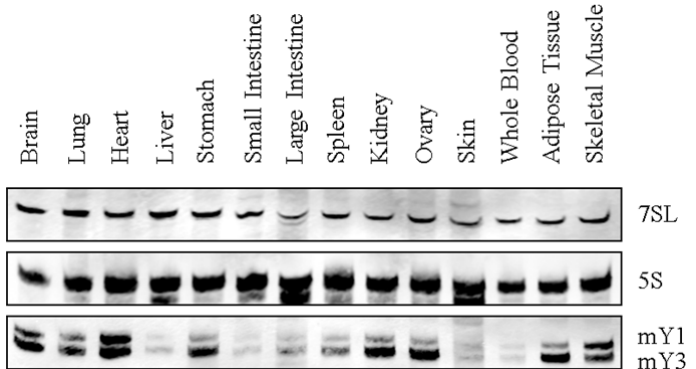
Figure 3. Y RNA expression in mouse tissues. A representative Northern blot for murine Y RNA tissue expression is shown. 7SL and 5S rRNA served as a loading control. Note that in mice, just Y1 and Y3 are